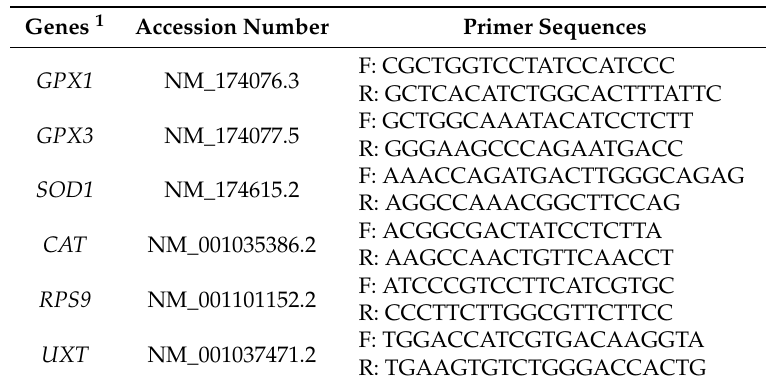
Table 1. Primer sequences used for Real-time